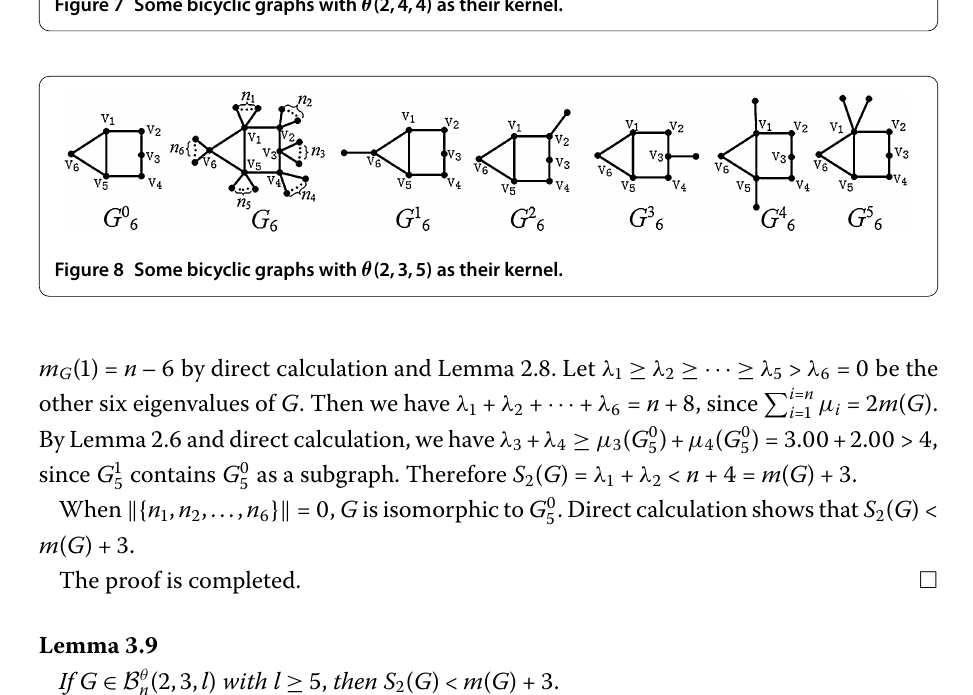
Figure 7 Some bicyclic graphs with θ (2,4,4) as their kernel.